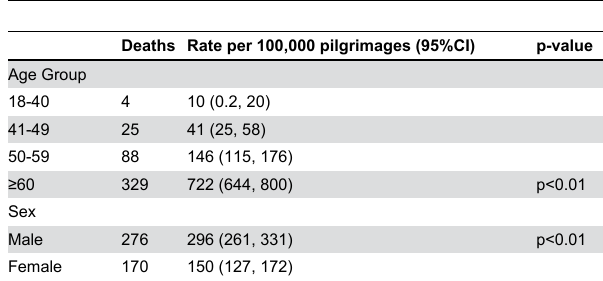
Table 2. Mortality rates of Indonesian pilgrims in 2008, total deaths = 446.